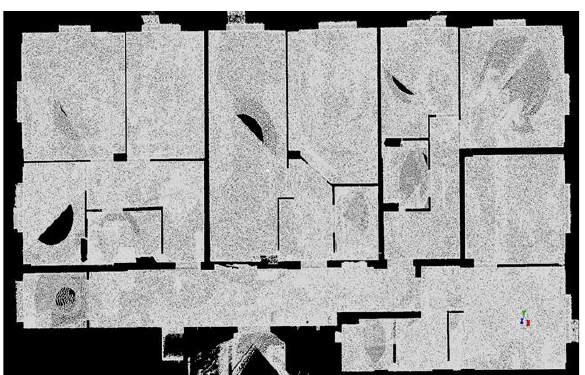
Figure 22 . Ceiling deviations from a plane in greyscale. Of importance is the determination of column displacements on each floor. By TLS data, a total of 650 columns were surveyed, and their displacements along the coordinate axis were determined. The example of a graph with columns' displacements is presented in Fig. 24. The second important parameter for the control is plate thickness. The plate thickness was checked for each floor. The example with thickness deviations is given in Fig.